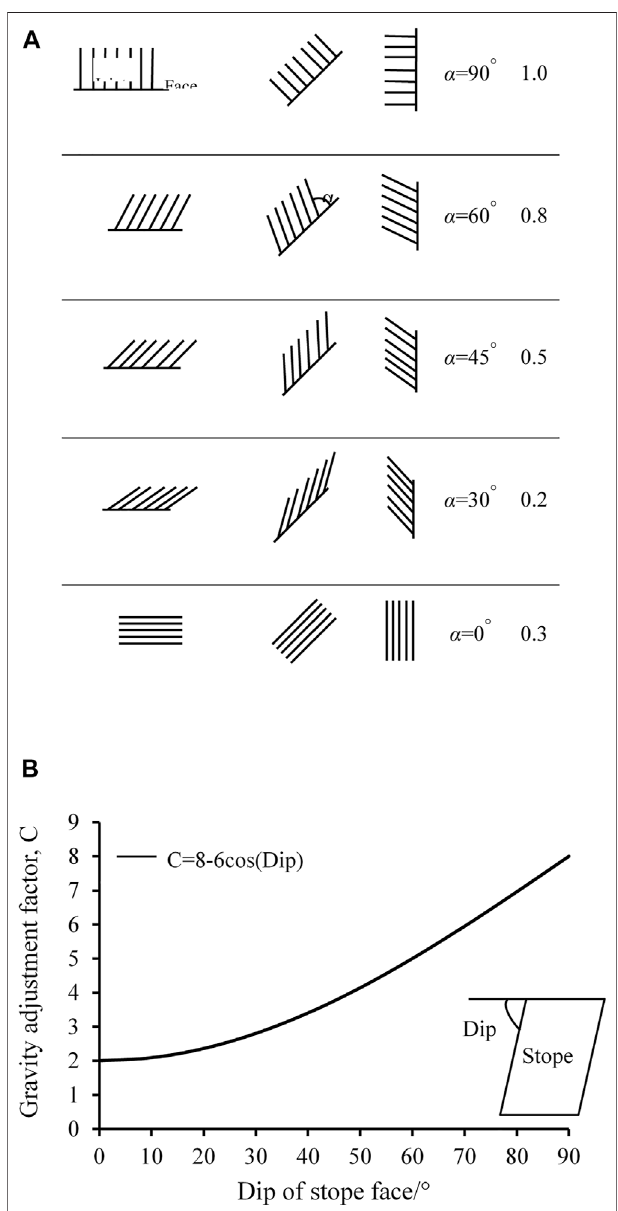
FIGURE 2 | (A) Joint orientation adjustment factor B and (B) cavity adjustment factor